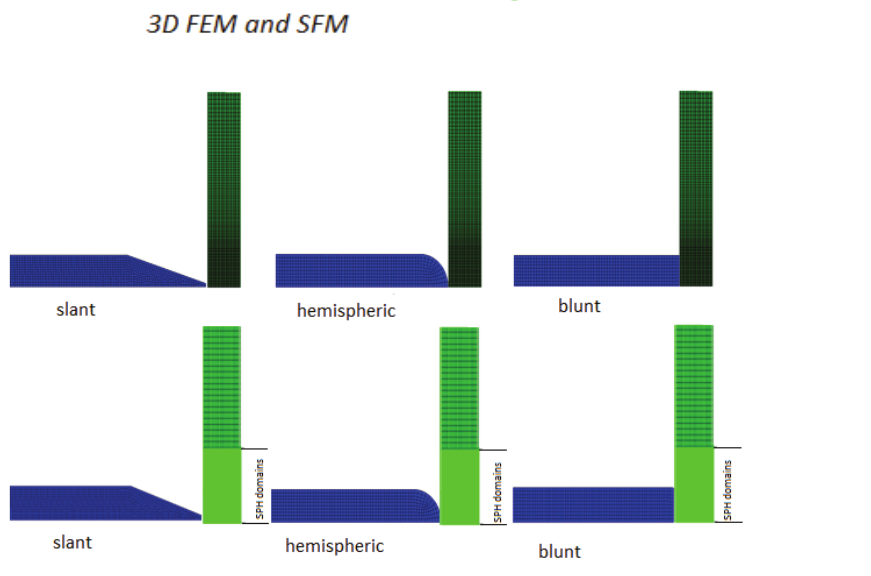
Figure 3 – 3D and 2D FEM and SFM projector networks and